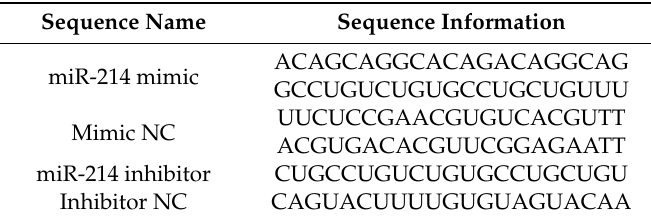
Table 3. Sequence information of miR-214 overexpression, interference, and negative